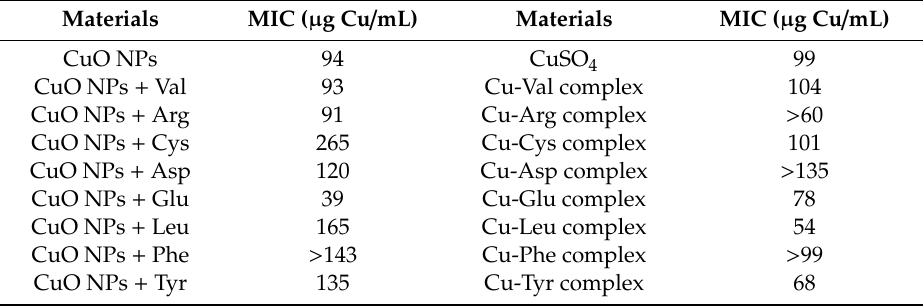
Table 4. Minimal Inhibitory Concentration (MIC) values of the di ff erent materials tested. All the concentrations refer to Cu content measured by ICP-MS (see Table 2).